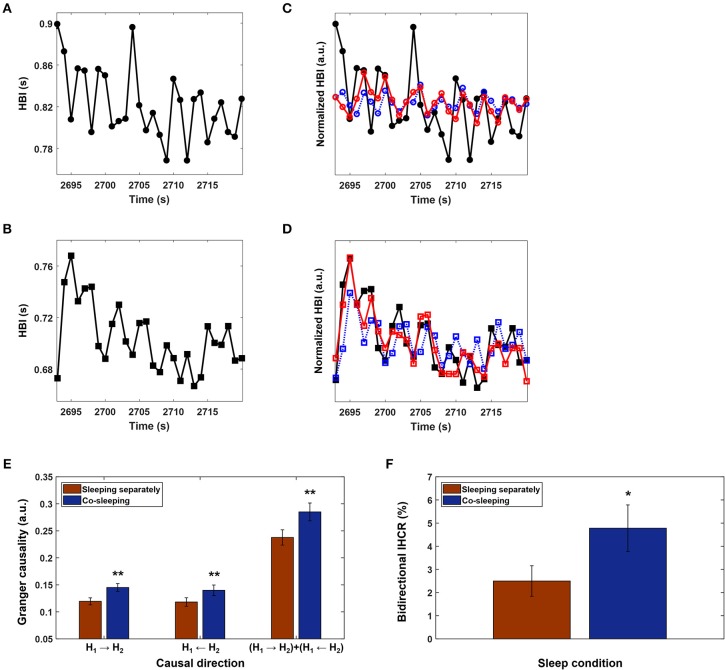
Interindividual heart rhythm causal relation (IHCR). (A) and (B) Heartbeat intervals (HBI) for a pair of co-sleeping individuals over 30 s that were resampled at 1 Hz to have a corresponding time resolution of 1 s. HBI were chosen as examples to explain the IHCR from the entire recordings of co-sleeping individuals. (C) The HBI in (A) predicted only using the past HBI in (A) (blue dashed line); the corresponding values predicted using both past HBI in (A) and (B) (red line), but the prediction did not improve. Therefore, the HBI in (B) does not have a causal influence on HBI in (A). (D) The corresponding procedure described in (C) is applied to HBI in (B). In this case, the prediction improves; therefore, the HBI in (A) has a causal influence on HBI in (B). (E) The mean IHCR obtained by averaging Granger causality for each directional influence of paired individuals' heart rhythms during the entire recordings in different sleep conditions. The error bars indicate the standard error. A significantly higher IHCR in both directions is shown in co-sleeping individuals (blue bars) than in individuals sleeping separately (red bars). Statistical significance is also observed when both directional influences are integrated (**p < 0.02 in all three cases, Wilcoxon signed-rank test). (F) The bidirectional IHCR is defined as the percentage of IHCR that is over the threshold (= 0.28) in both directions; this threshold was determined to be twice the average IHCR. The error bars show the standard error. The mean bidirectional IHCR is significantly higher in co-sleeping individuals than in those sleeping separately (*p < 0.03, Wilcoxon signed-rank test), demonstrating that one individual's present heart rhythm is influenced by the other individual's past heart rhythm in both directions during co-sleeping, i.e., the heart rhythms interact with each other.